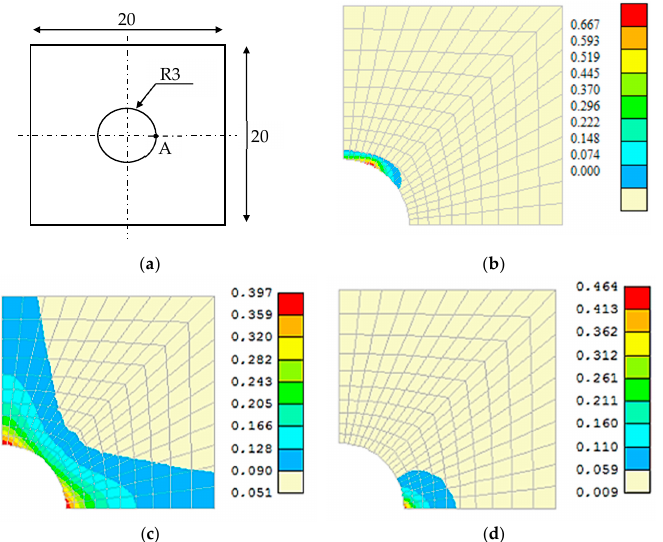
Figure 1. Square plate with a circular hole, ( a ) geometry, ( b ) α = 0.5, ( c ) α = 1, ( d ) α = 1.5.